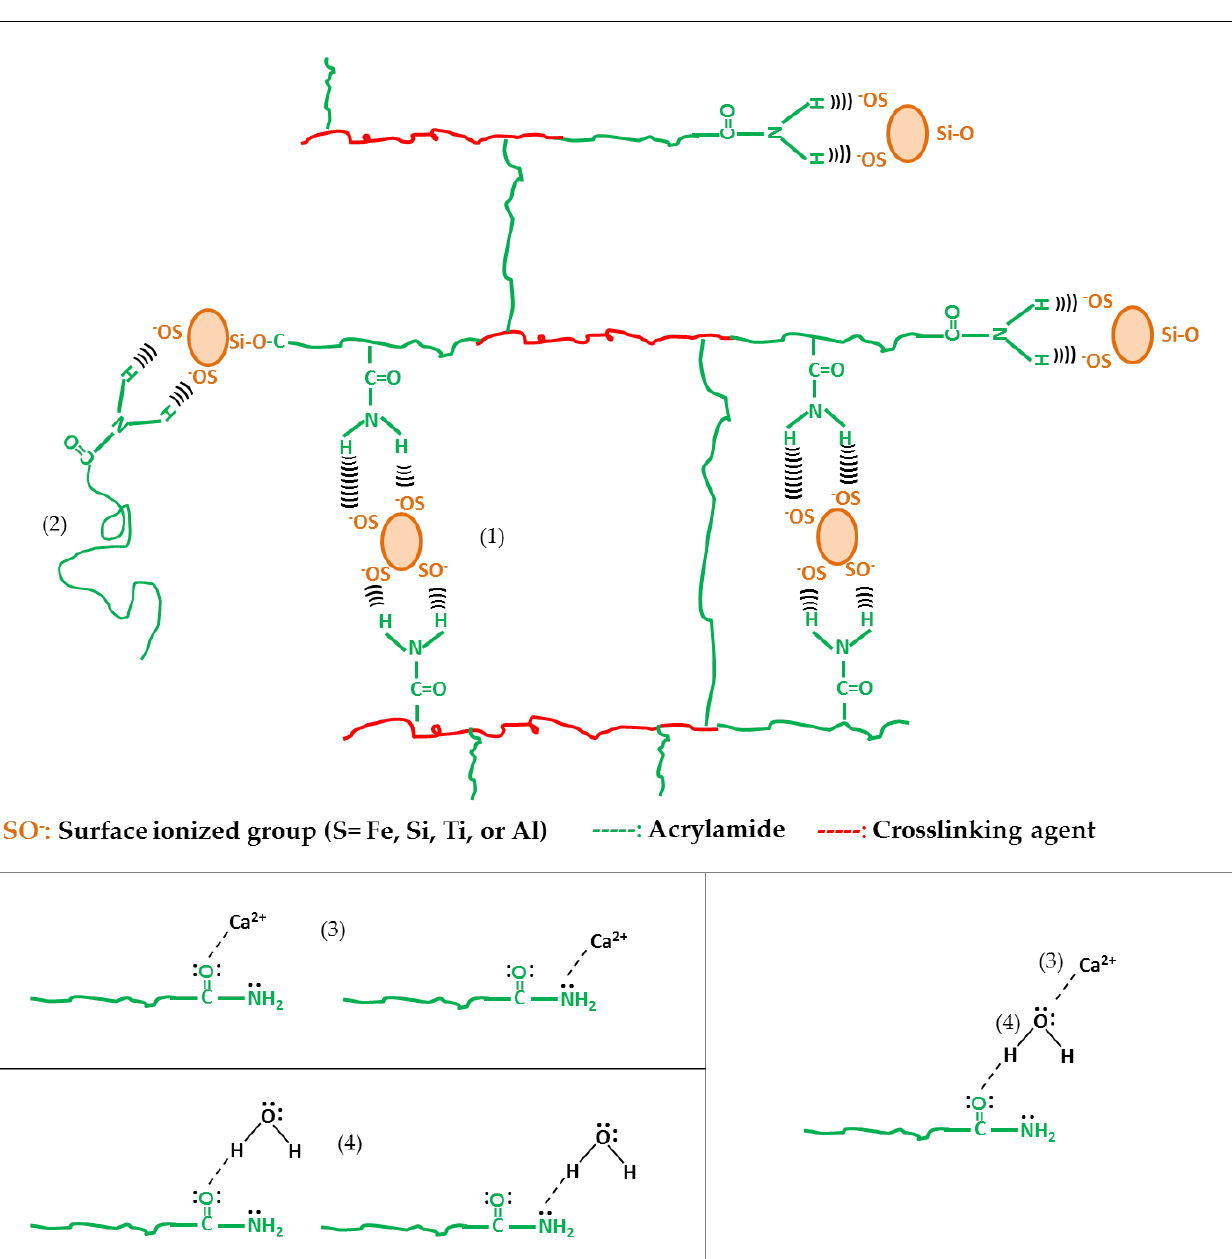
Figure 16. Microstructure for the polyacrylamide/RM hybrid hydrogel and the possible interactions between both phases: ( 1 ) physical crosslinking by hydrogen bonding, ( 2 ) physical insertion, ( 3 ) ion- dipole interaction between polyacrylamide and the exchangeable cation, ( 4 ) hydrogen bonding between polyacrylamide and interlayer water.